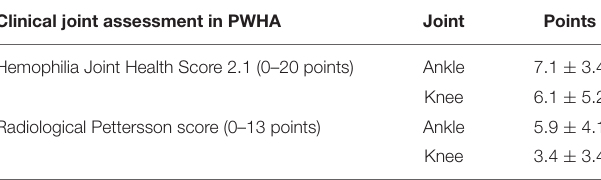
TABLE 2 | Clinical joint assessment. Clinical joint assessment in PWHA Joint